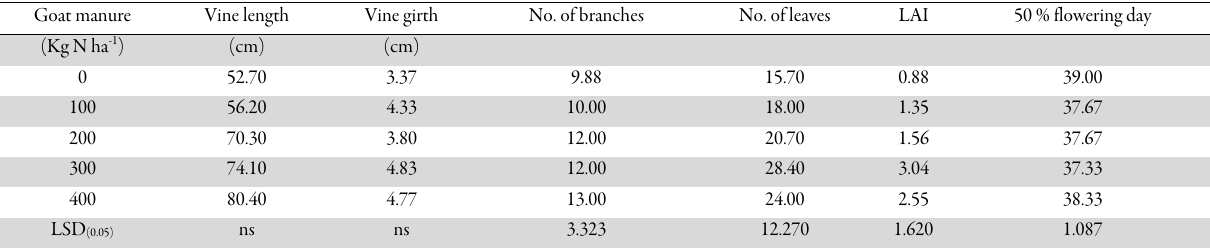
Table 1. Growth of cucumber ( Cucumis sativum ) as influenced by different rates of goat manure application at 50 % flowering day Goat manure Vine